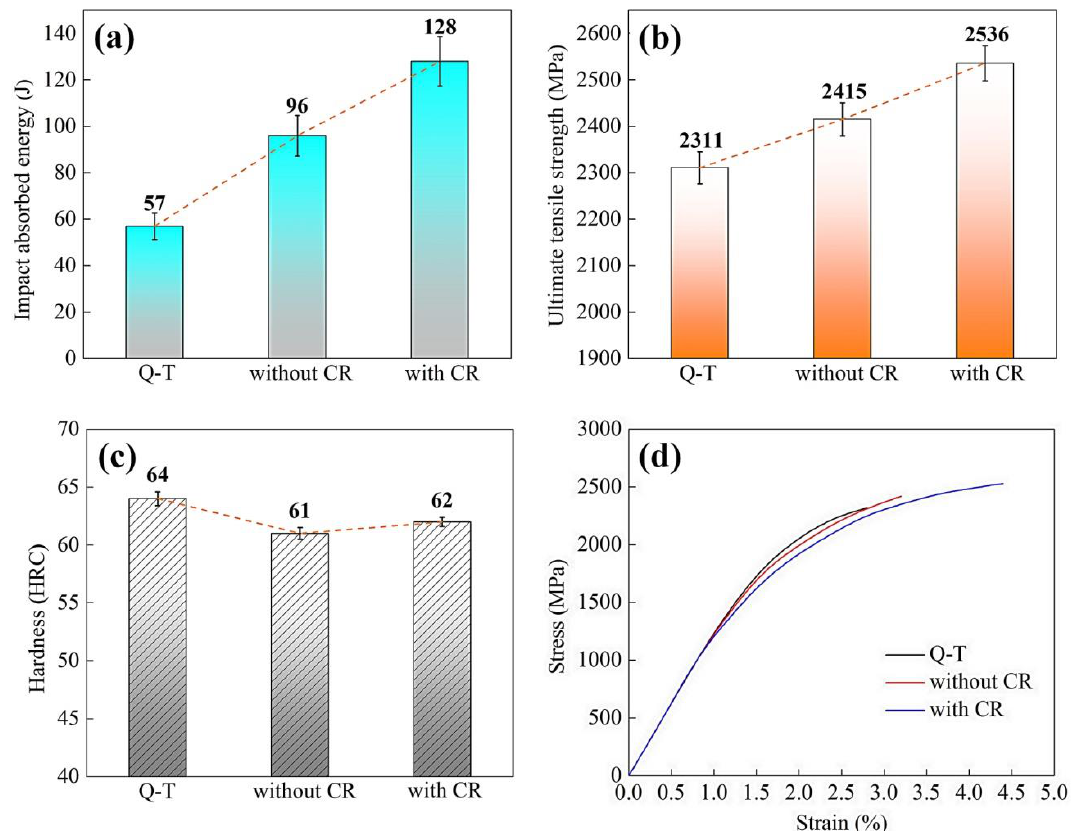
Figure 9. Mechanical properties of specimens subjected to Q-T process and austempering process without and with CR after tempering: ( a ) impact toughness; ( b ) ultimate tensile strength; ( c ) hardness; ( d ) the stress-strain curves. ( d ) the stress-strain curves.